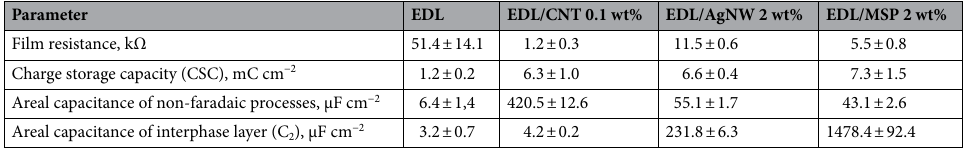
Table 2. Summary of electrical parameters of pristine EDL, EDL/CNT 0.1 wt%, EDL/AgNW 2 wt% and EDL/ MSP 2 wt%.